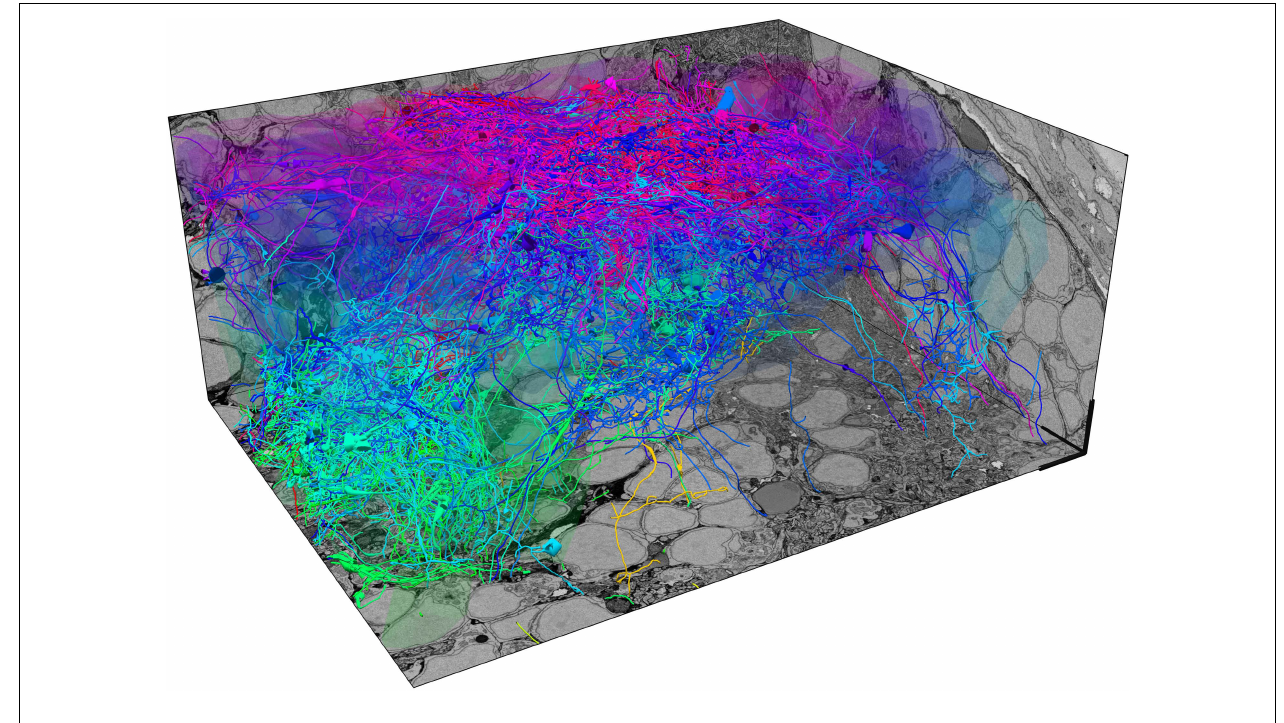
human tracers. Skeletons represent the consensus of the three reconstructions for each neuron.The diameter of skeletons represents the variation in the redundant reconstructions, providing a rough estimate of the neurite’s diameter. Neurons are color-coded according to their soma location along the z-axis. Scale bars: 5 μ